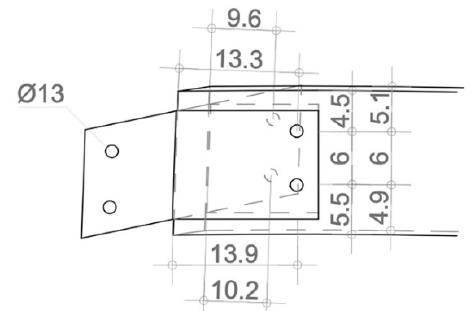
Figure 13. Detail with steel plate dimensions of the designed steel joint.